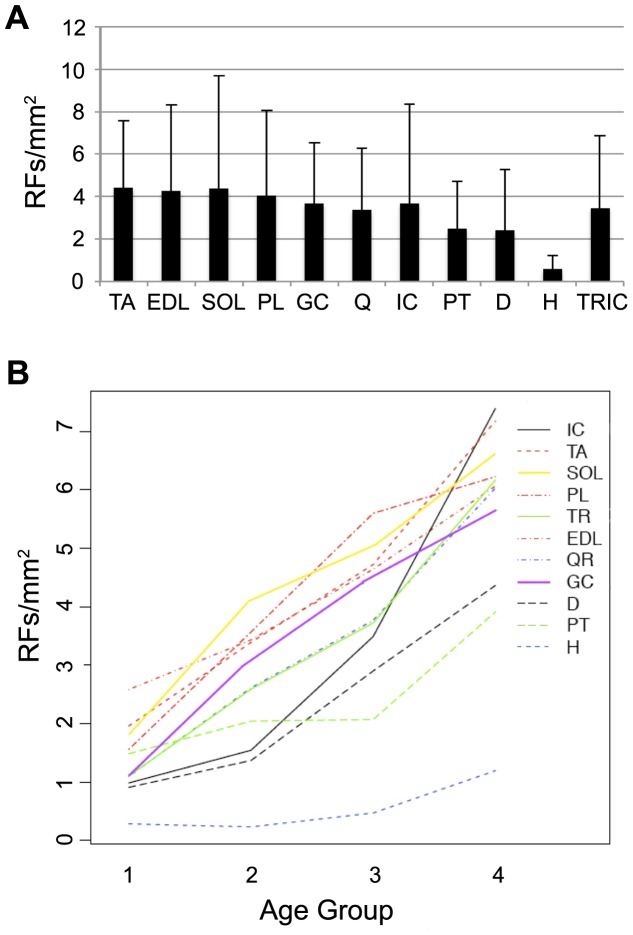
Number of revertant fibers (or of cardiomyocytes, in the case of heart) per square millimeter in different muscles.(A) Values calculated without differentiating between age groups; numbers were obtained by averaging the single RF/mm2 value of each of the 10–12 sections per muscle, for all forty mice. Abbreviations are as follows: TA, tibialis anterior; EDL, extensor digitorum longus; Q, quadriceps; SOL, soleus; GC, gastrocnemius; PL, plantaris; D, diaphragm; H, heart; IC intercostal; PT, pectoralis; TRIC, triceps. (B) Interaction between the number of revertant fibers per square millimeter (Y-axis) and the age of the animals (X-axis). For each muscle, the segmented line joins the four values of RFs/mm2, one for each age group; data were obtained by averaging the counts of all the sections, 10–12 per muscle, for ten animals. Note that the order of the muscles’ names at the right side of the chart reflects the order of the values found for group 4.